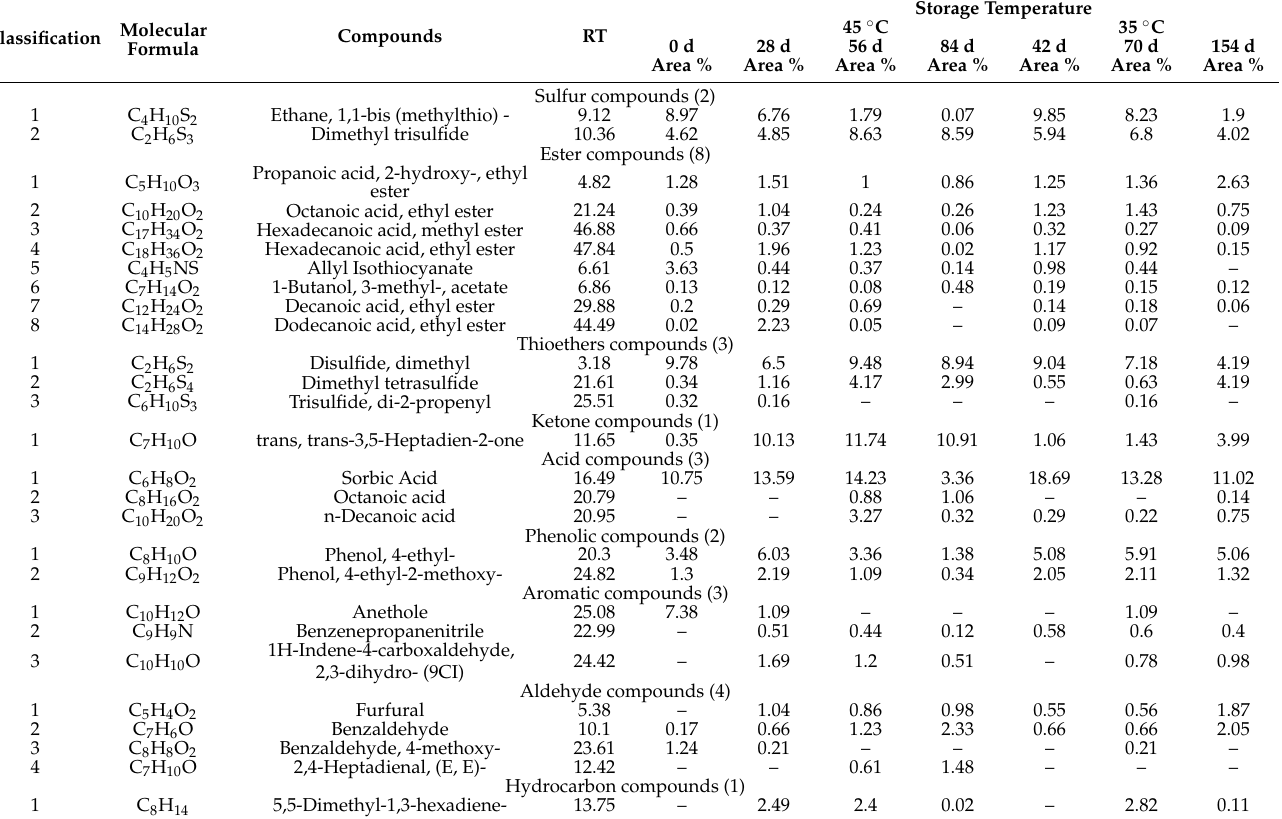
Table 4. Changes of volatile components in Sichuan sauerkraut during storage (45 ◦ C, 35 ◦ C).